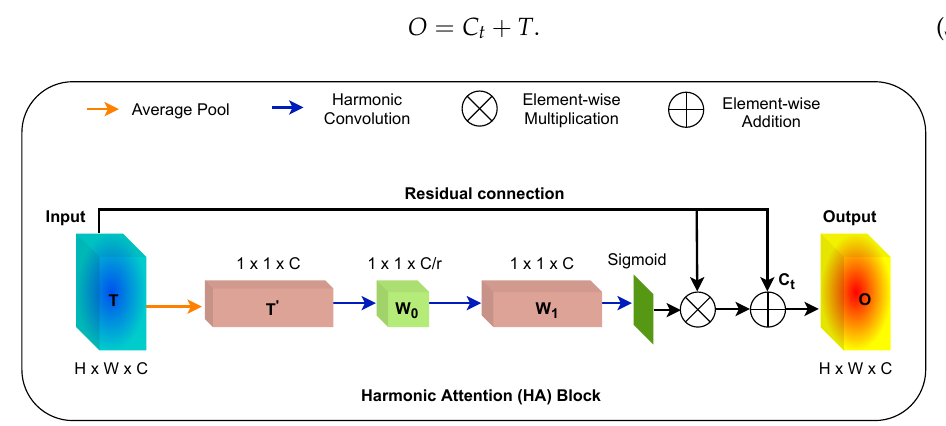
Figure 3. Illustration of harmonic attention (HA)